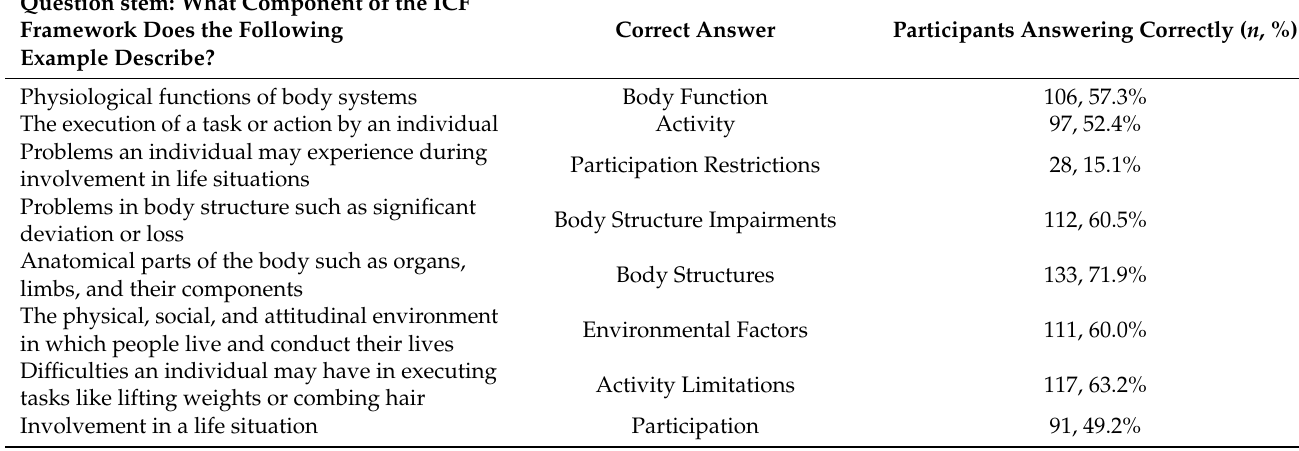
Table 3. Participant knowledge scores related to the different components of the ICF framework.